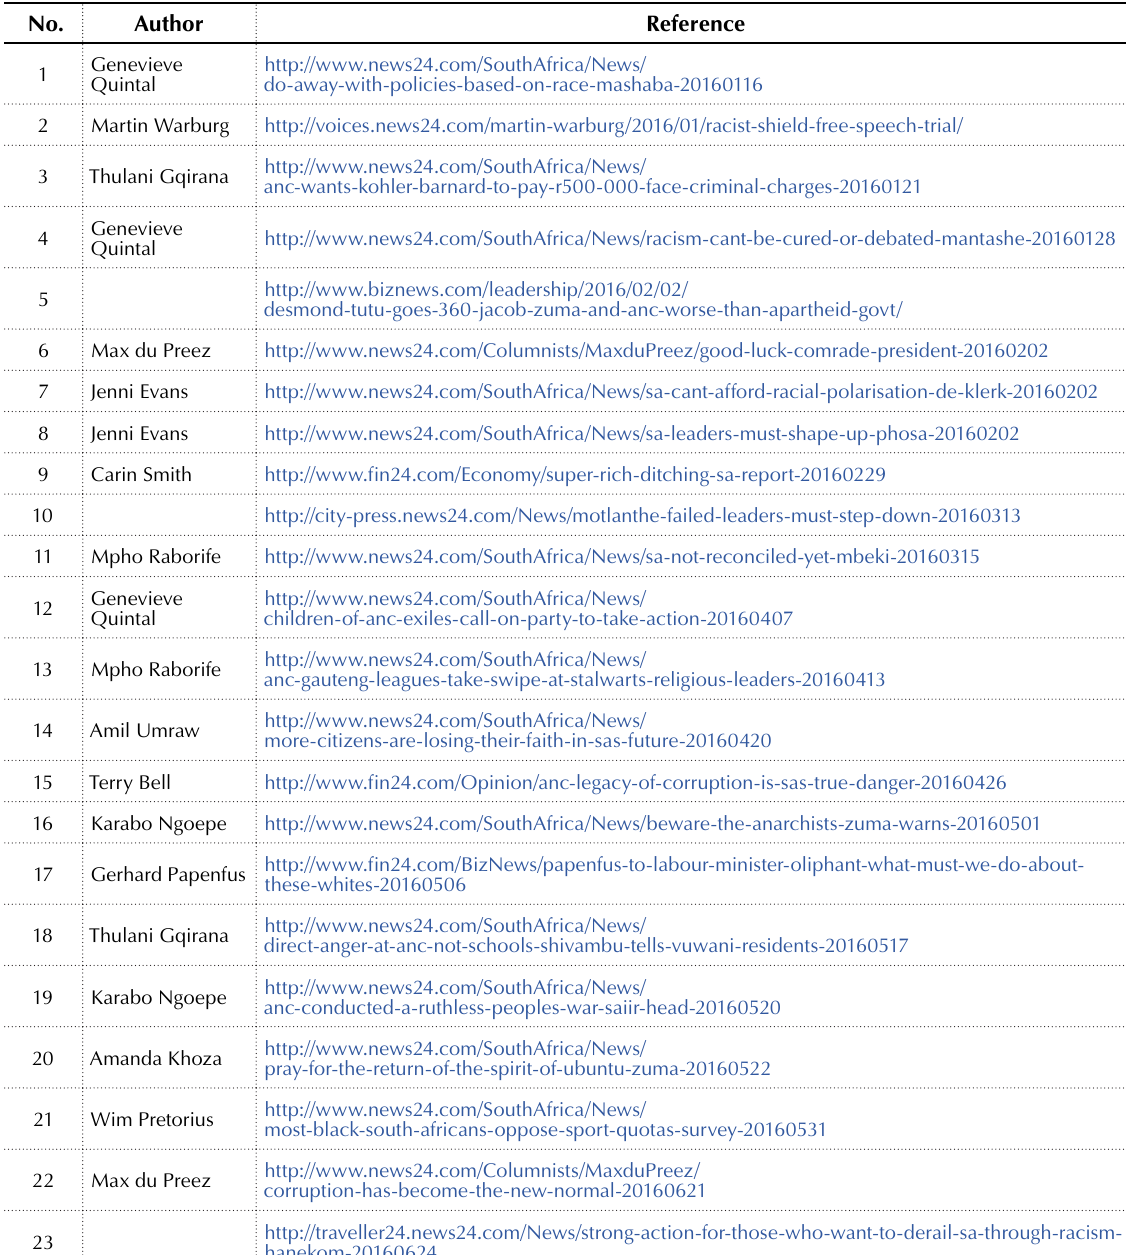
Table 4A. Technological macro-environment (January-June 2016) No. Title